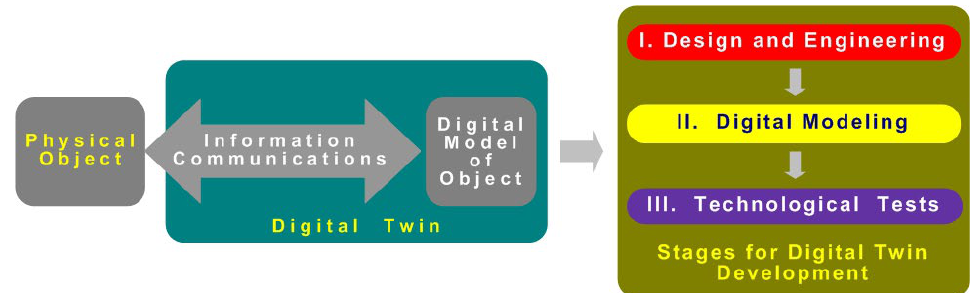
Figure 1. Digital twin and stages for its development.